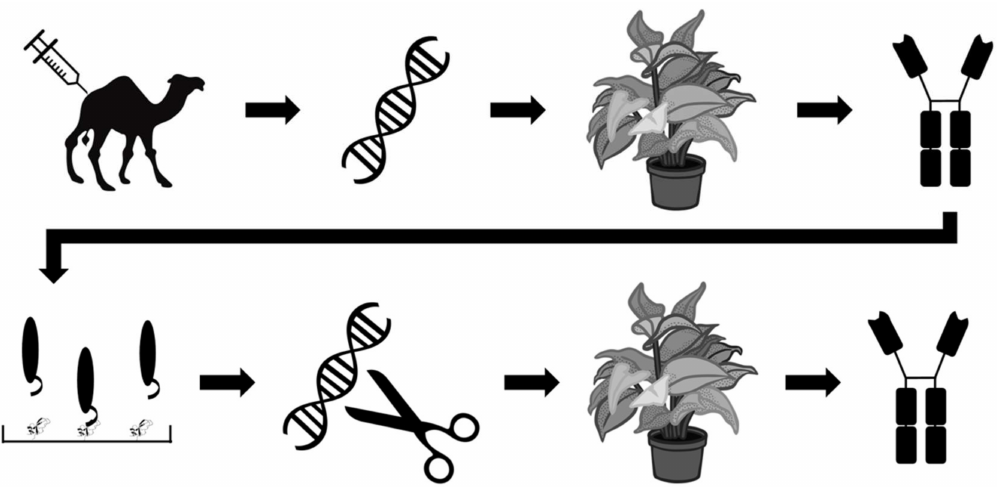
Figure 7. Schematic overview of the strategy employed by Julve Parreño et al. [53]. Dromedaries were immunised with a mixture of venoms. V H H sequences were extracted from the immunised animals, cloned into a viral vector, and used to infect Nicotiana benthamiana specimens. The plant-expressed V H Hs were evaluated in vivo and subjected to phage display experiments involving four venom fractions from Bothrops asper (representing the four important major toxin families of this venom) to accumulate high affinity V H Hs. The 36 best V H H binders were converted to human-dromedary chimeric antibodies, which were expressed in N. benthamiana as well and tested in